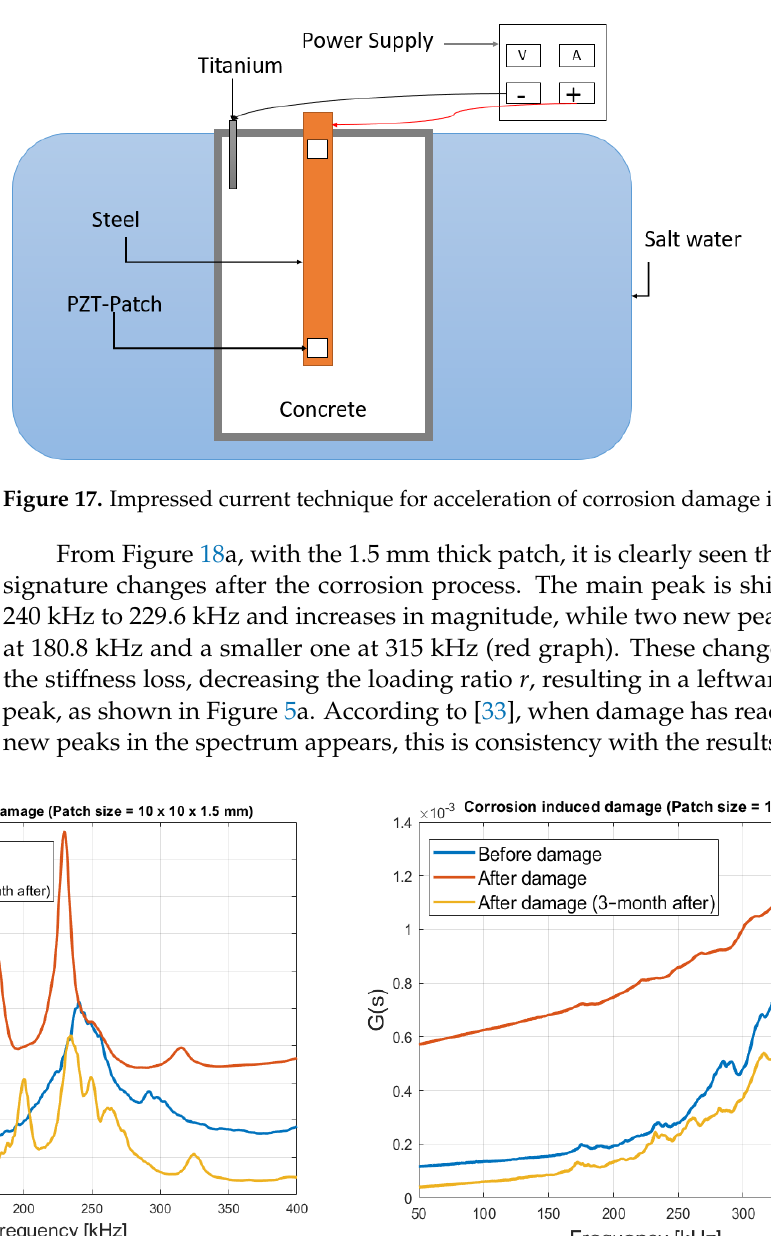
Figure 17. Impressed current technique for acceleration of corrosion damage in RC structure.